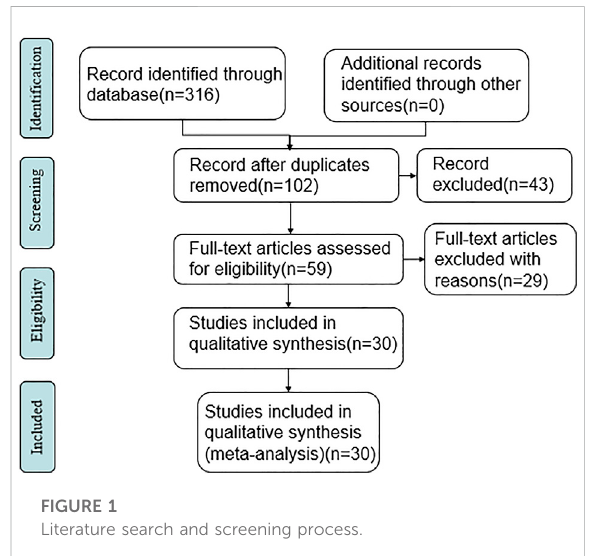
FIGURE 1 Literature search and screening